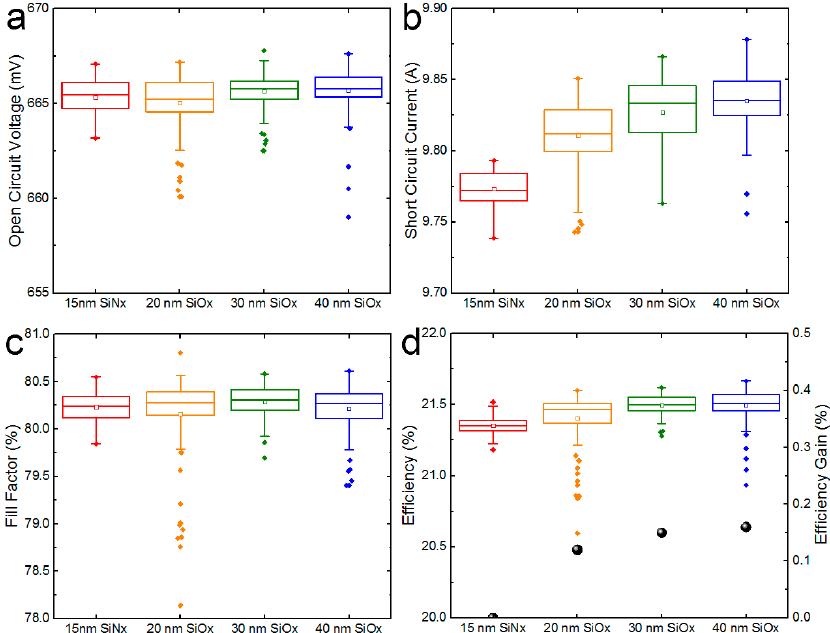
Figure 4. Box plots of the photovoltaic parameters ( a —open circuit voltage, b —short-circuit current, c —fill factor, and d —efficiency) of the monocrystalline silicon PERC solar cells fabricated with different third layers of antireflection coating. Each group contained about 100 solar cells. The outliers and mean values are represented by solid lozenges and hollow squares. The solid black spheres in d represent the median efficiency gains compared with the 15 nm SiN x group. Table 2. The photovoltaic parameters of the monocrystalline silicon PERC solar cells fabricated with different third layers of antireflection coating. Each group contained about 100 solar cells, and the median values are listed.